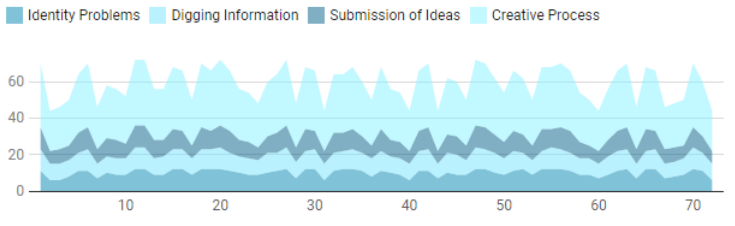
Figure 3. Statistics of creative process activities (source: created by